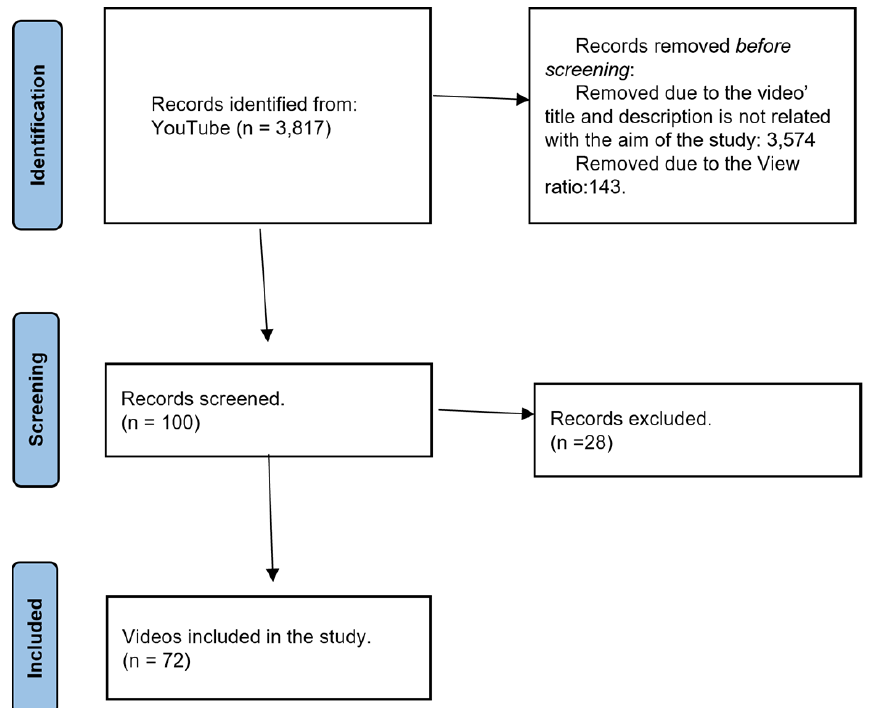
Figure 1. Decision flow chart, based on PRISMA flowchart.